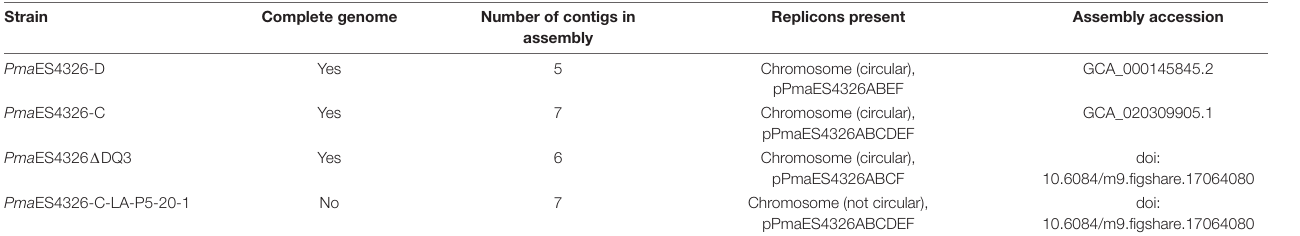
TABLE 2 | Assembly of Pma ES4326